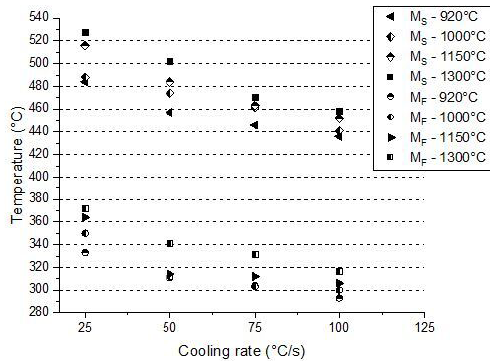
Figure 17. Effect of the cooling rate upon the martensitic start and finish temperatures for the austenitizing temperature of